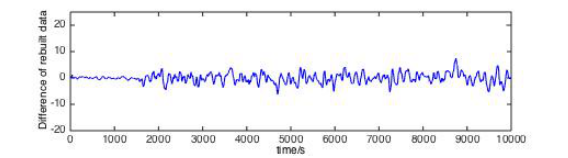
Figure 12. Differential detector result without